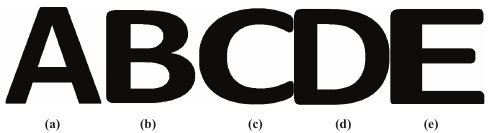
Figure 7. Five color cover images with photos of birds: ( a ) BCI 1 ( b ) BCI 2 ( c ) BCI 3 ( d ) BCI 4 ( e ) BCI 5 .